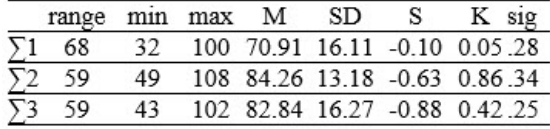
∑1= family function score ∑2 = predictors of the quality of family functioning score ∑3 = certain aspects of the educational function